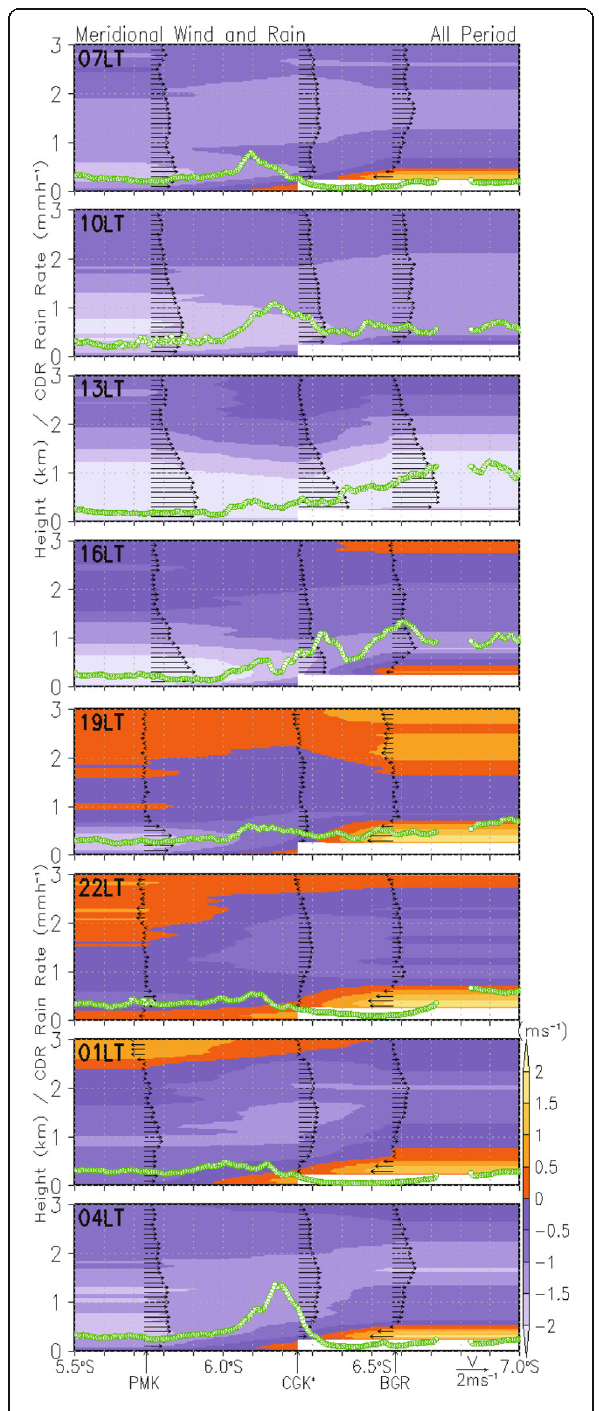
Fig. 7 Diurnal meridional circulations over Jakarta. Cross-sectional views of diurnal meridional circulation over Jakarta obtained by the multi-point sounding array averaged for the campaign period (color shades and wind vectors) with the meridional distribution of the CDR estimated rain rate at a height of 2 km (green lines with small circles) averaged over a 100-km width in the east – west direction from Serpong. Pramuka, Cengkareng, and Bogor indicate the sounding stations at the coastal sea over the Jawa Sea (north), the coastline (center), and the mountain foothills (south),